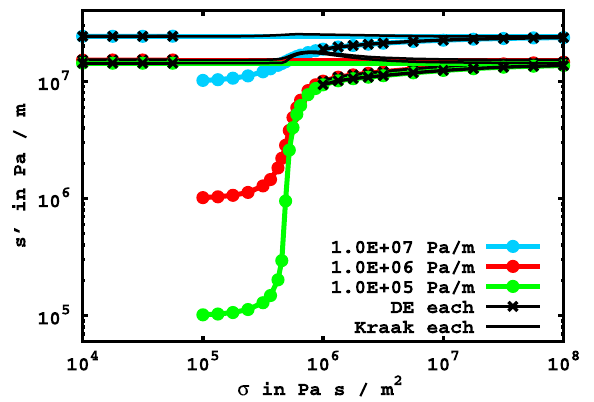
Figure 12. Dynamic stiffness per unit area s 0 for different values of the porosity e according to the legend: the exact value, s the calculation according to [2] using the standard procedure, the calculation according to the German preamble of [3] (DE), and calculation according to Kraak (22).